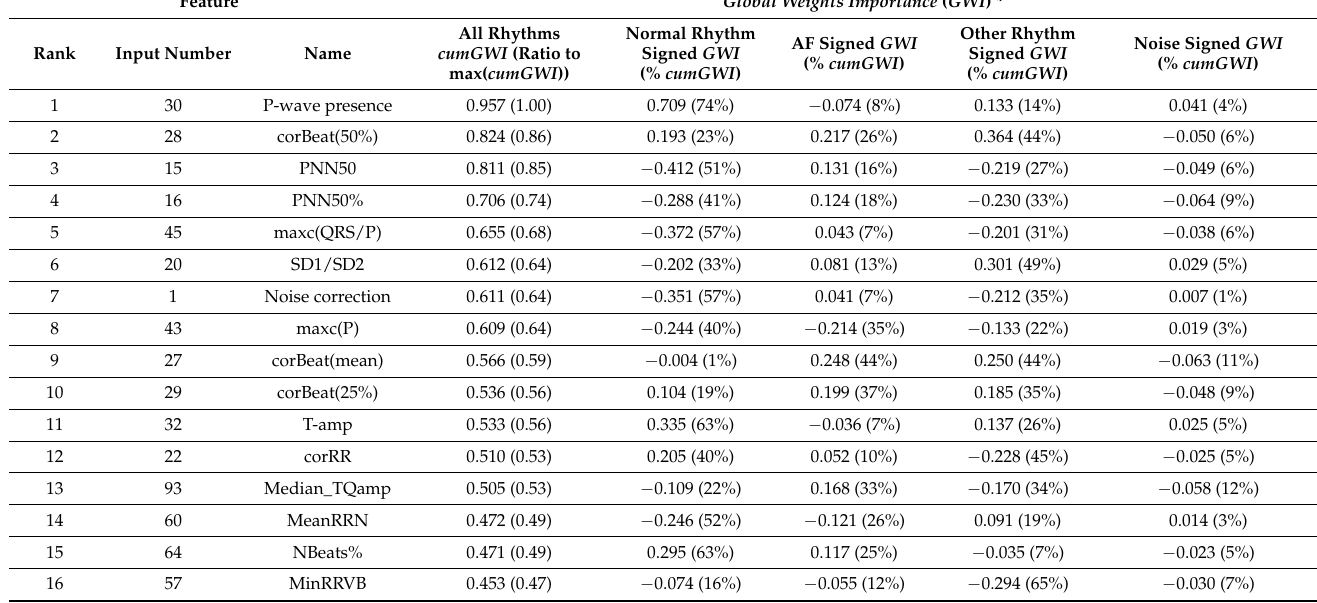
Table 4. List of the top-20 features ranked in Figure 7 by maximal stacked Global Weights Importance accumulated over all rhythm classes ( cumGWI ). The reported values present signed mean values of Global Weights Importance computed for each class by 20 × 5-fold independent runs of DenseNet-3@128-32-4 model. Normalized values are additionally reported (in brackets): (1) Columns ‘Normal Rhythm’, ‘AF’, ‘Other rhythm’, ‘Noise’: the proportion of Global Weights Importance of specific class to the cumulative value for all classes cumGWI ; (2) Column ‘All rhythms’: the ratio of cumGWI of specific feature to the maximal cumGWI of the top-ranked